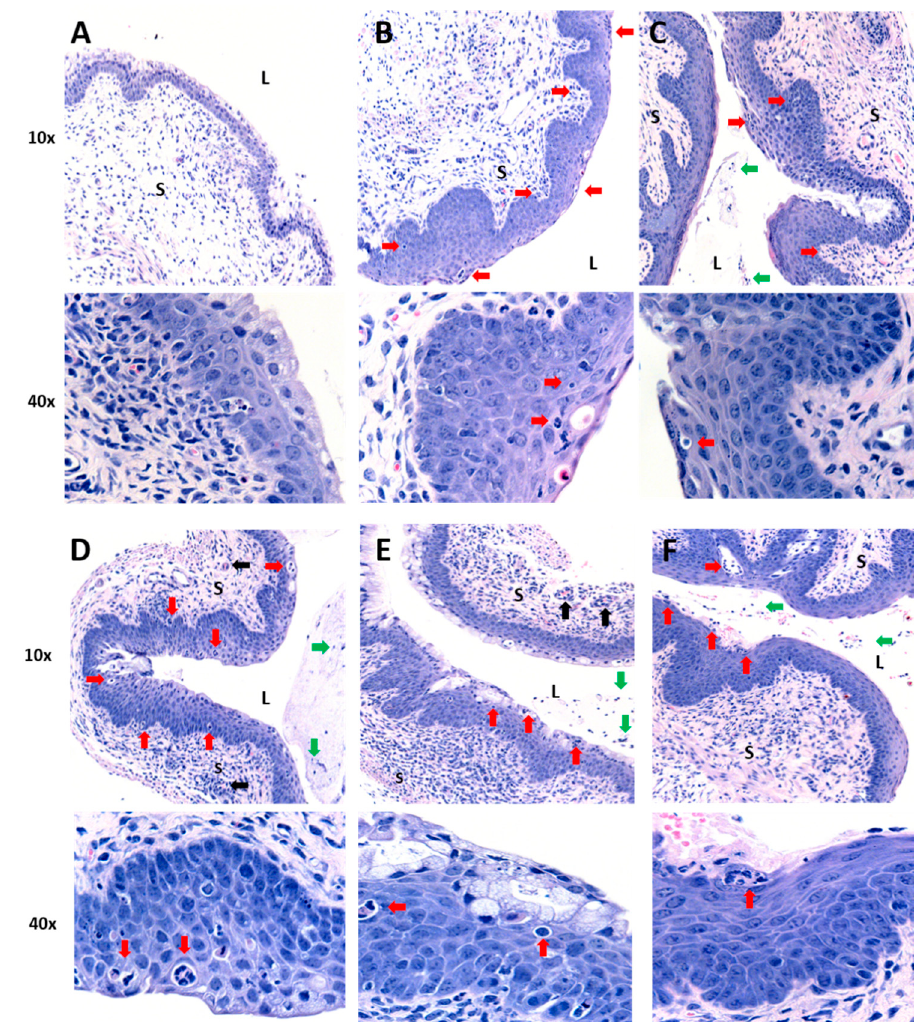
Figure 1. Histology of vaginal tissues from mice treated with curcumin nanoparticles by intraperitoneal or oral delivery and challenged with CpG-oligodeoxynucleotide (ODN). All mice were depo-treated ( n = 3–6 per group). ( A ) Mice received water with no CpG-ODN (negative control). All other groups ( B – F ) received intravaginal (IVAG) inoculation with 30 µg CpG-ODN 4 h after primary treatment with: ( B ) water (positive control), ( C ) 1.25 mg of curcumin in nanoparticles IP, ( D ) vehicle-only nanoparticles IP, ( E ) 1.25 mg of curcumin in nanoparticles orally, or ( F ) vehicle-only nanoparticles orally. Vaginal tissues were fixed in formalin, sectioned and stained with H&E. Images are representative from vaginal tissue of 1 animal per treatment group, with magnifications of 10× and 40×. L denotes vaginal lumen and S denotes the vagina submucosa. Red arrows indicate thickened vaginal epithelium and/or inflammatory cell infiltration in the epithelium and submucosal tissue. Black arrows indicate inflammatory cell infiltrates in the blood vessels. Green arrows indicate inflammatory cells in the luminal space.